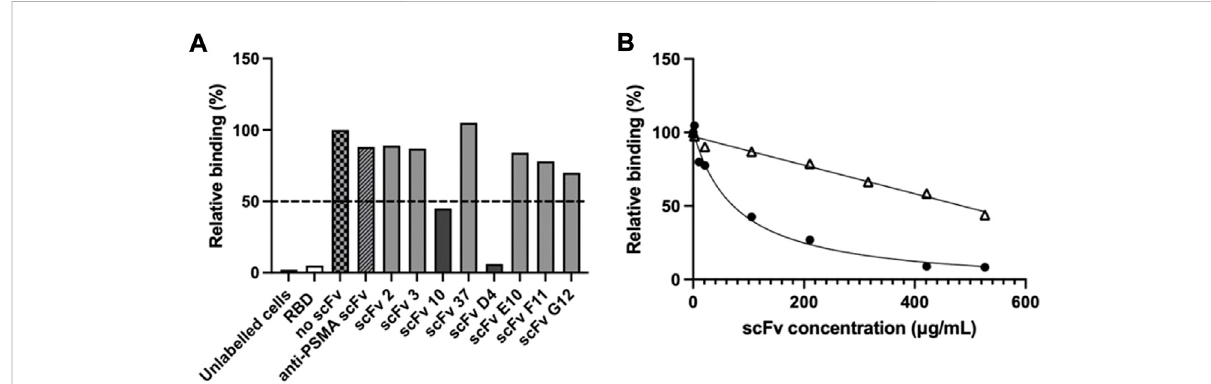
FIGURE 3 Inhibition ofRBDbindingtoACE-2 cells byscFvs.Flow cytometry wasusedto determine inhibition ofRBD-ACE-2 binding. (A) AlexaFluor 647- labelled SARS-CoV-2 RBD was pre-incubated with scFv (100:1 scFv:RBD ratio), prior to incubation with ACE-2-expressing Vero E6 cells. Unlabelled cells, cells pre-incubated with unlabelled RBD ( “ RBD ” ), cells pre-incubated with Alexa Fluor 647-labelled RBD but no scFv ( “ no scFv ” ), cells pre- incubated with Alexa Fluor 647-labelled RBD and an irrelevant “ anti-PSMA scFv ” were used as controls. Values show single measurements. The dottedlineindicates50%inhibitionofRBD-cellbinding. (B) IC 50 determinationofRBDbindingtoACE-2cellswithinhibitoryscFvs10( △ )andD4( C ). 80 nM Alexa Fluor 647-labelled SARS-CoV-2 RBD was pre-incubated with scFv 10 or scFv D4 prior to addition to Vero E6 cells. Cells incubated with RBD-Alexa Fluor 647 without scFv were used as a control. Values show single measurements. The IC 50 was calculated with GraphPad Prism version 9.3, using fi tting to a four-parametric nonlinear regression